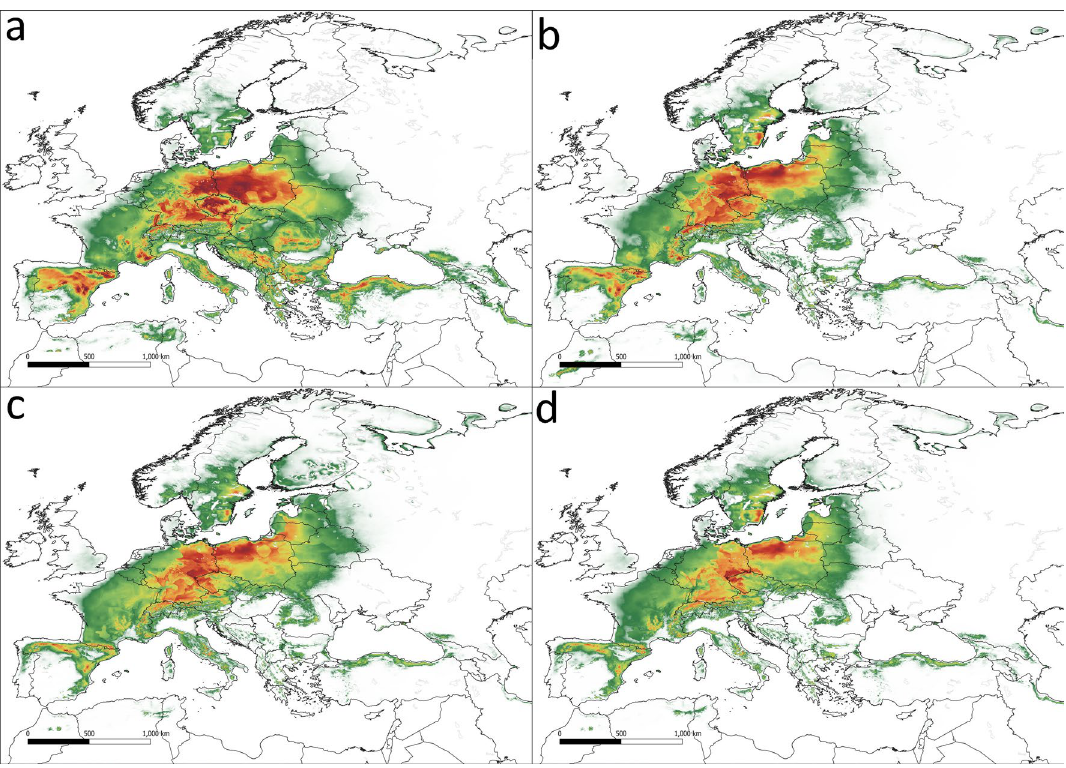
Figure 5. The potential range of Viscum album subsp. austriacum . ( a ) current conditions, ( b ) scenario SSP 1.26, ( c ) scenario SSP 3.7, ( d ) scenario SSP